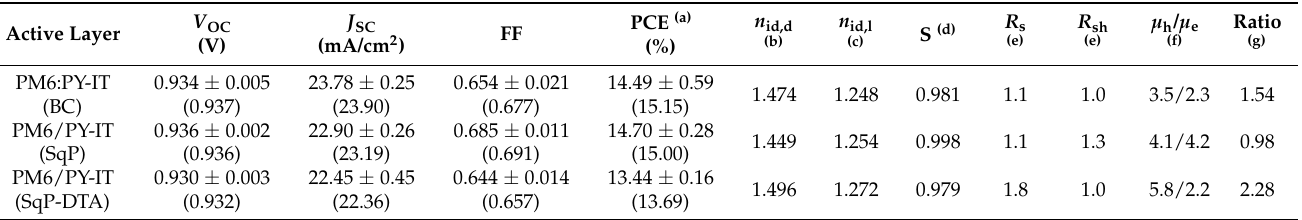
Table 1. Summary of photovoltaic parameters for PM6 and PY-IT-based all-PSCs processed from different conditions, measured under AM 1.5 G illumination at 100 mW cm − 2